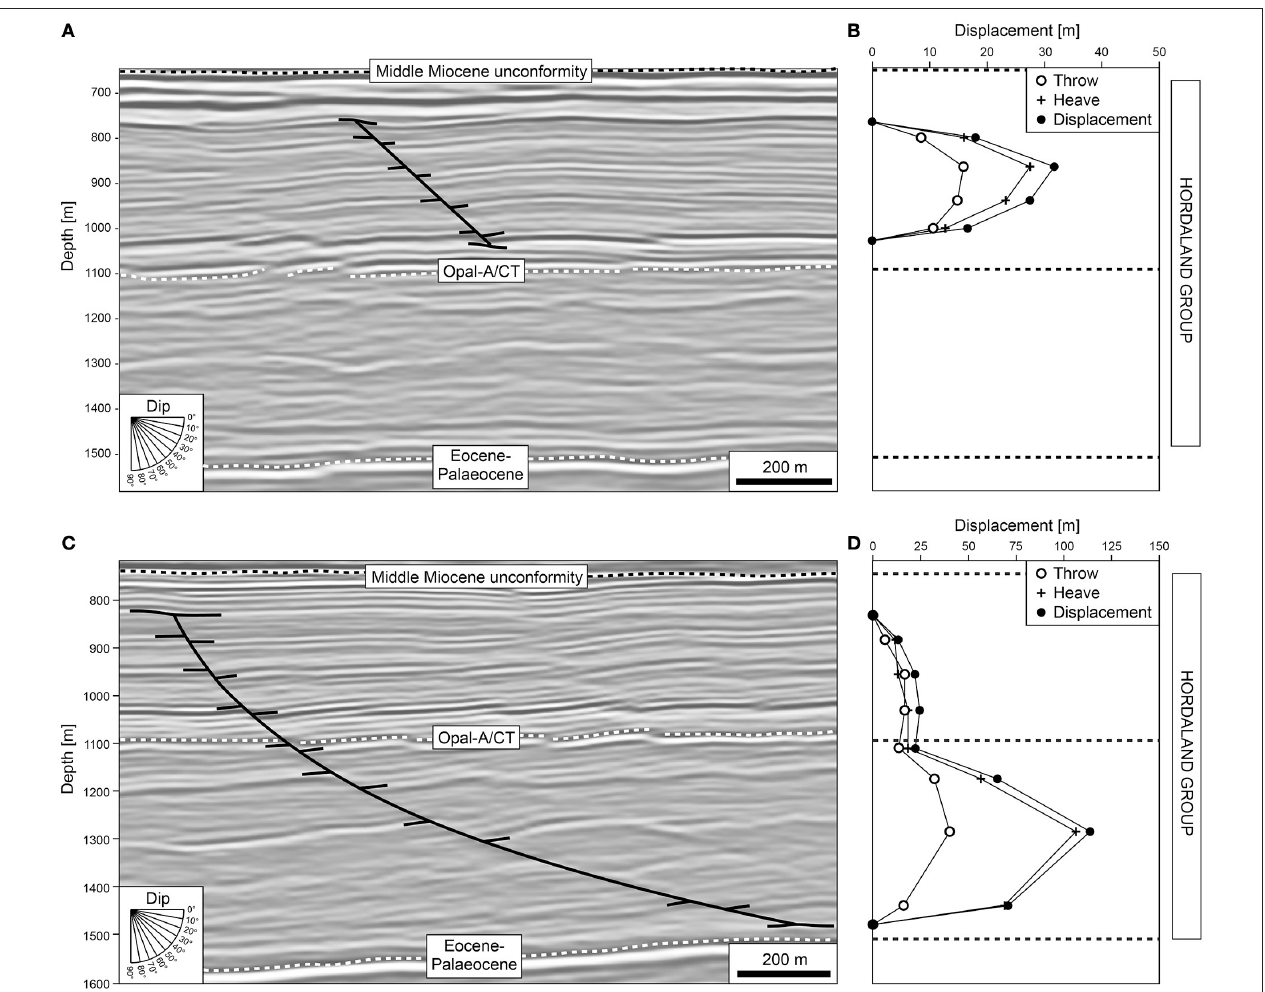
back to isolated fault traces in the lower Hordaland Group ( Figure 5H